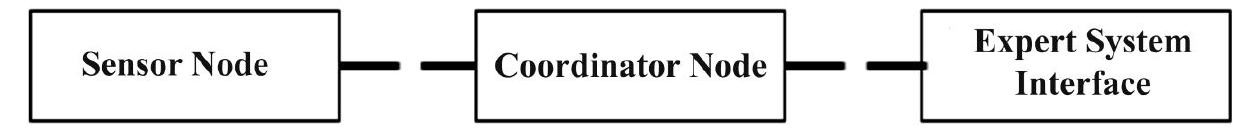
Figure 6. Data transmission through